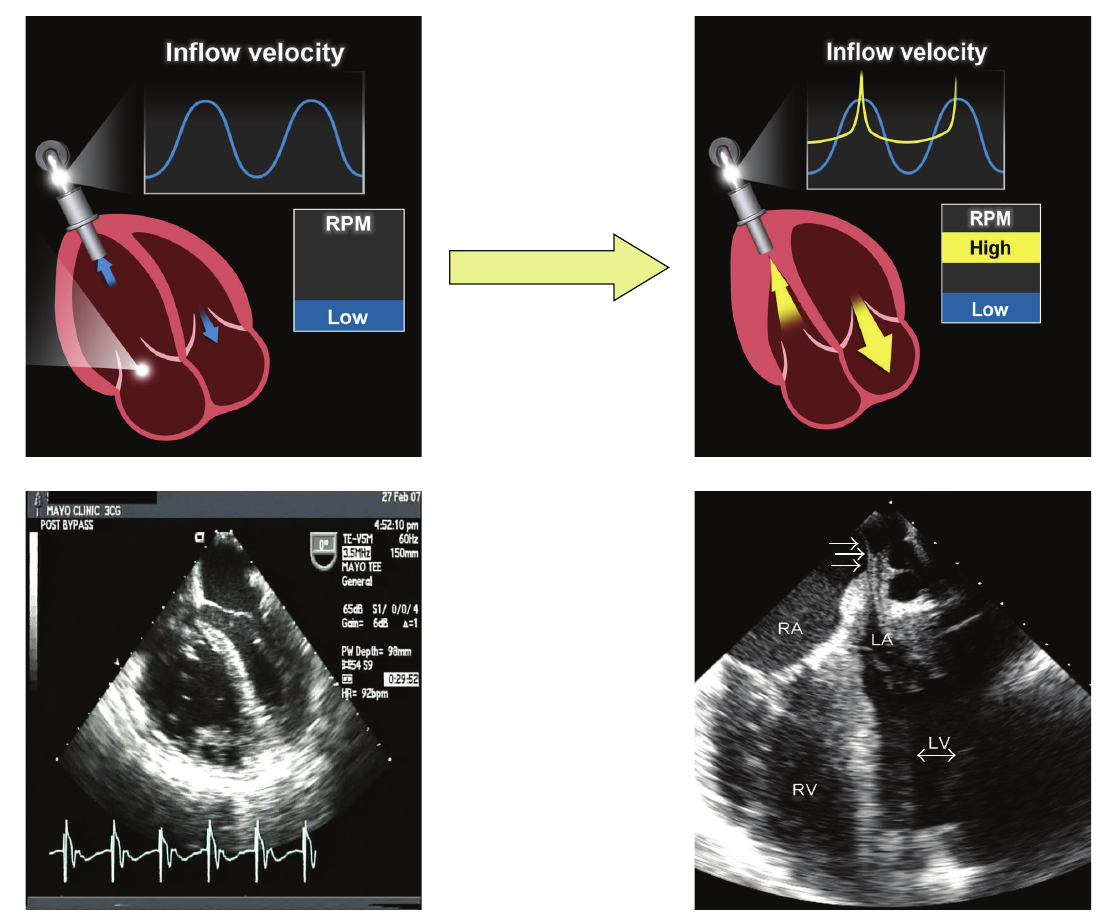
Figure 4: Inflow cannula obstruction, the “suction cascade”. Four-chamber transthoracic view representing the classic “suction cascade” that can manifestitself by a dilated hypocontractile RV, significant functional TR, small left ventricle, and intermittent inflow cannula obstruction by the collapsed